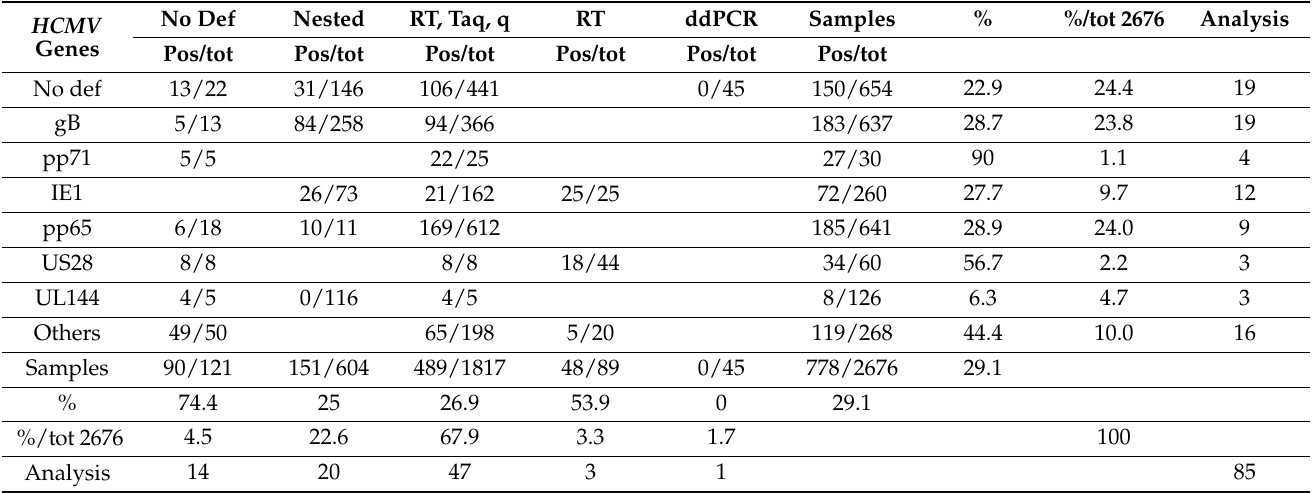
Table 6. Detection of the HCMV genome in GBM tissue specimens using PCR